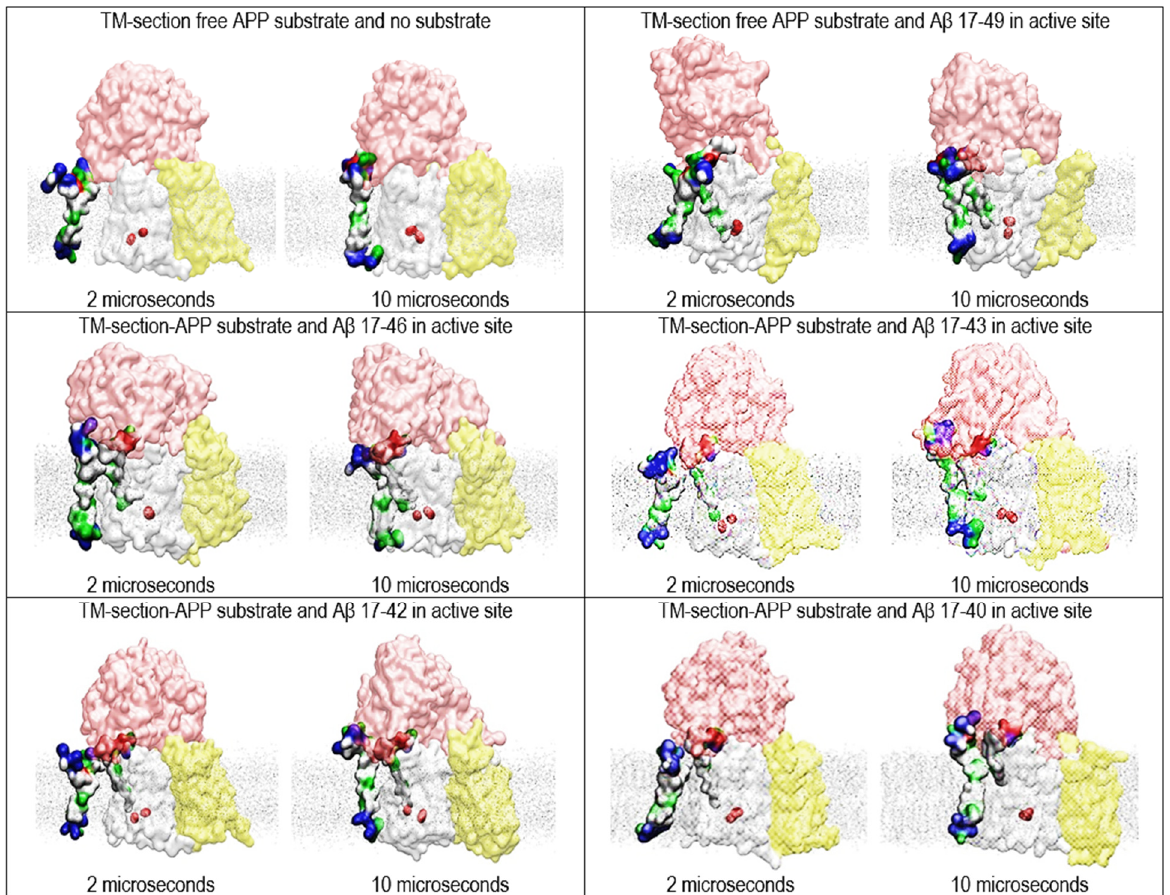
Figure 5. Multiscale MD studies of the docking of the short forms of free substrates to γ -secretase: substrate fragments bound in the active site (PDB:6IYC [46] ). The γ -Secretase complex is depicted as partially transparent Connolly surfaces, showing nicastrin (pink), presenilin 1 (white), Aph1 (yellow), and Pen2 (not visible) [43] . Red beads depict the active sites Asp 257 and Asp 385. The surfaces of the two substrates are shown as hydrophobic (white), negative (red), positive (blue), and polar non-charged (green). The cholesterol–lipid bilayer is shown as silver dots. The calculations used substrate forms of different length to show how substrate length can affect the presented two-substrate mechanism. The free substrate shows the NMR structure, starting with V12-H13-H13-Q15 and ending with 53K-54K-55K-Q56-57Y (PDB:2LP1 [33] ). The substrates bound in the active site tunnel had different lengths of A β 17-x, representing different catalytic intermediates that can come from the 83- α -CTF-APP substrate [11,13]. The short N-terminal domain of the bound substrate is hidden under the nicastrin ectodomain [46] . We compared the structures at the first contact between the free substrate and γ -secretase (at 2 µs) with the structures of the fully formed complex (at 10 µs). The figures show that even the shortest substrates can form contacts that can affect dynamic changes in presenilin’s structure that drive processive catalysis [13].